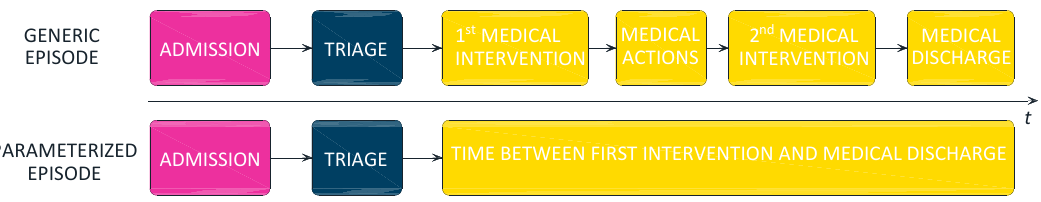
Figure 9. Generic episode flowchart and parameterized flowchart considered in this case.